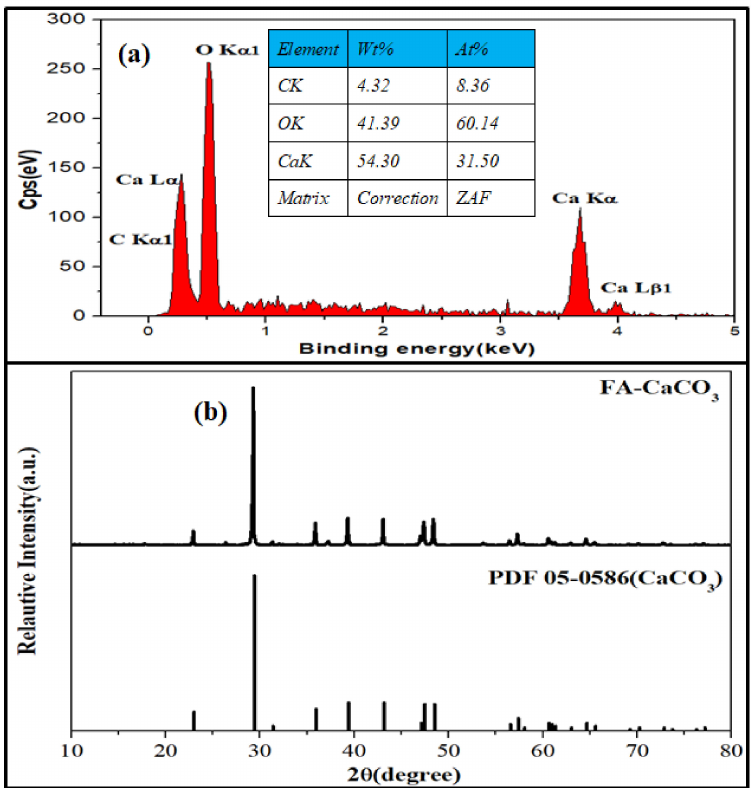
Figure 3. ( a ) EDS and ( b ) XRD pattern of FA-CaCO 3